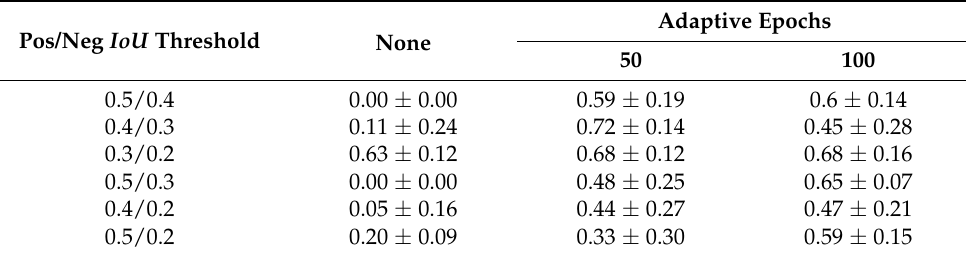
Table 5. Location accuracy of the studied RetinaNet models as a function of the threshold and the number of adaptive epochs. Each value is expressed as mean and standard deviation.